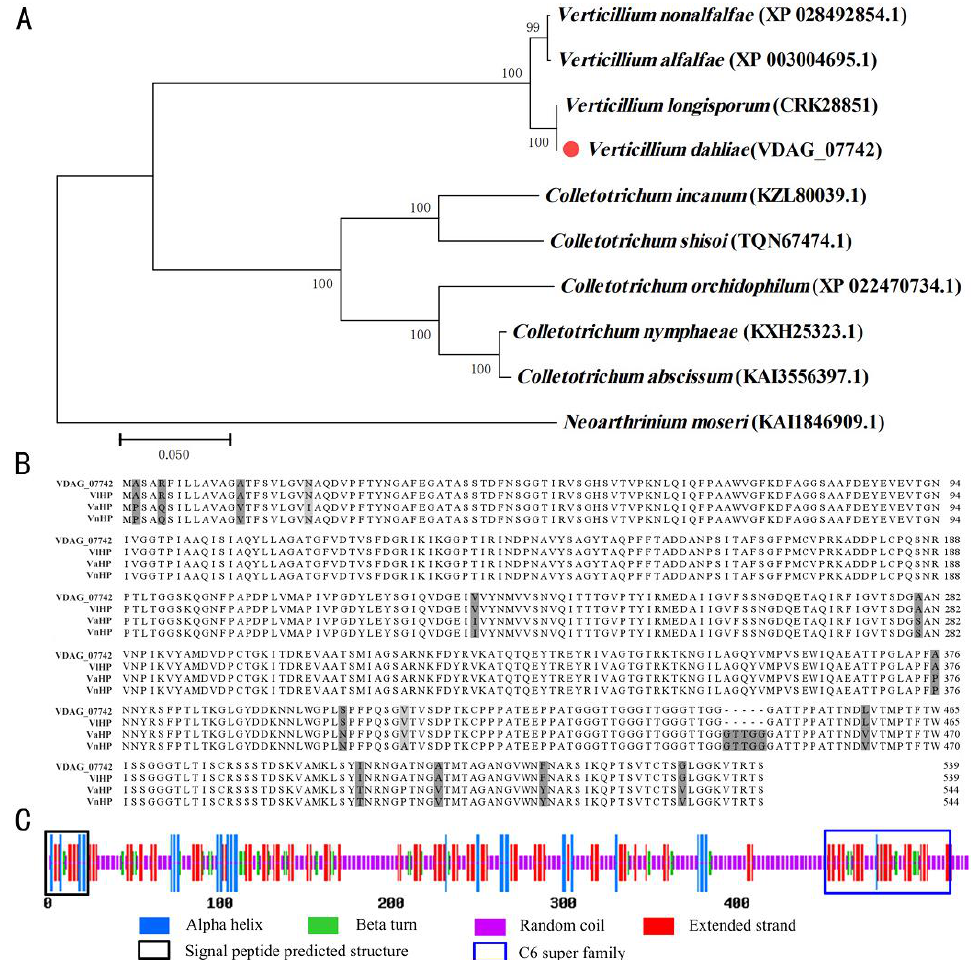
Figure 5. Characterization of VDAG_07742 in Verticillium dahliae . ( A ) Phylogenetic tree constructed using the MEGA7.0 neighbor-joining method using 9 fungal amino acids with bootstrap percentages obtained from 1000 replicates at each branch node and the red dot represented the amino acid sequence of VDAG_07742; ( B ) multiple sequence alignments showing homologous proteins in V. nonalfalfae , V. alfalfae, and V. longisporum ; Non-conserved amino acid residues were shaded in gray and the darker the color, the less conserved the residue. ( C ) secondary structure prediction of VDAG_07742.